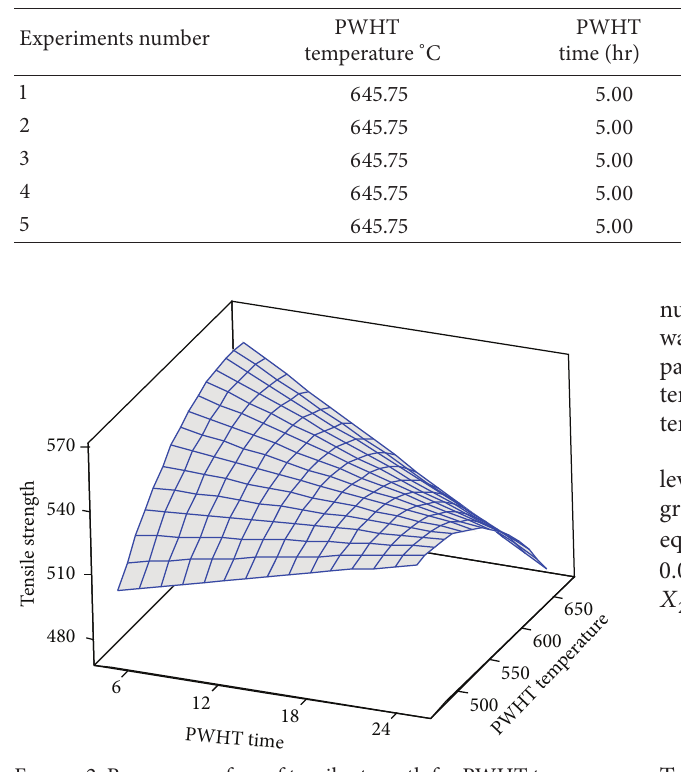
Figure 2: Response surface of tensile strength for PWHT tempera- ture and time.